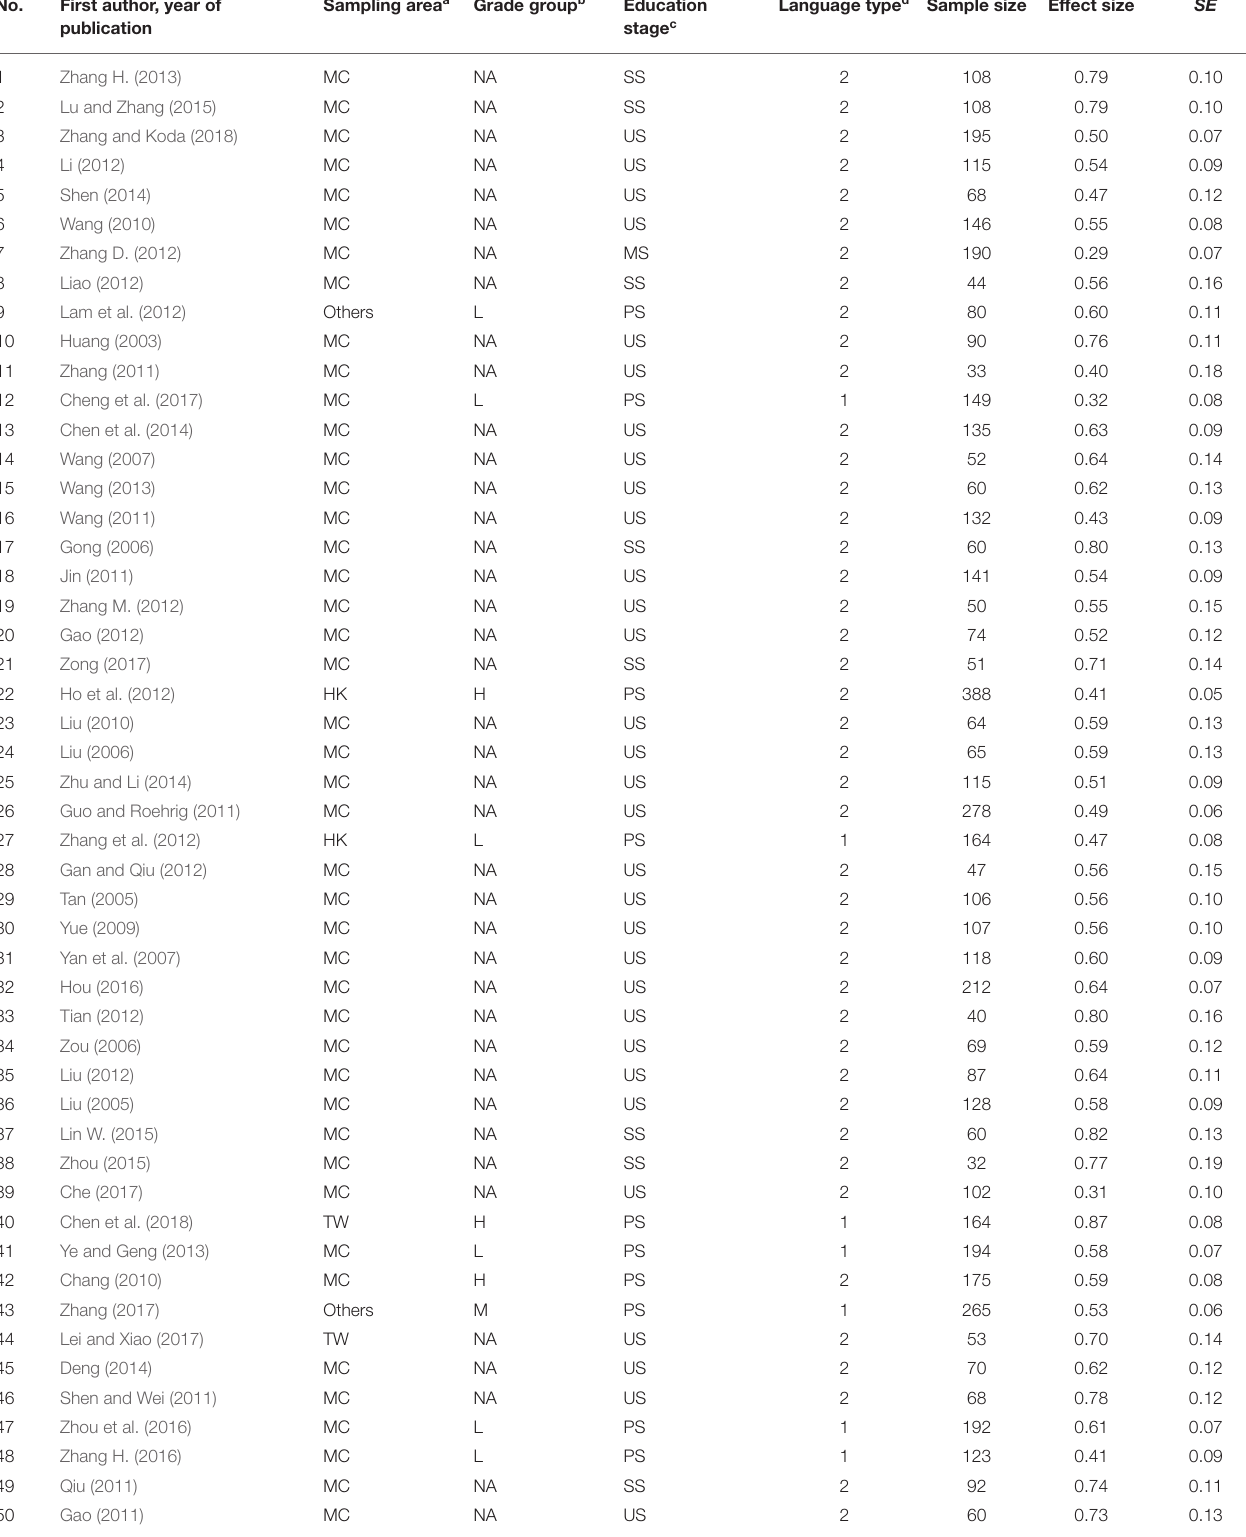
TABLE 1 | Descriptive information of the selected